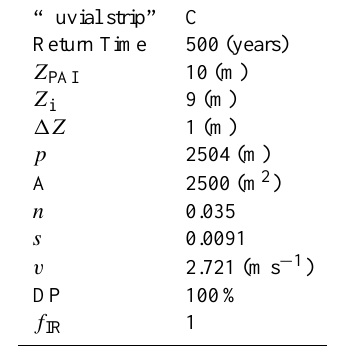
Table 1. Data used to characterize the magnitude of the natural event and the resulting damage probability (DP) and factor of in- crement of the risk ( f IR ) for the case study